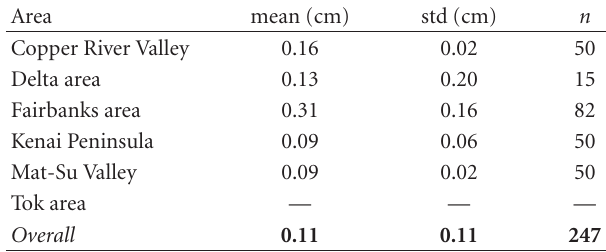
Table 3: Di ff erences between predicted and observed bark thickness with the Alaska model on post-sample white spruce